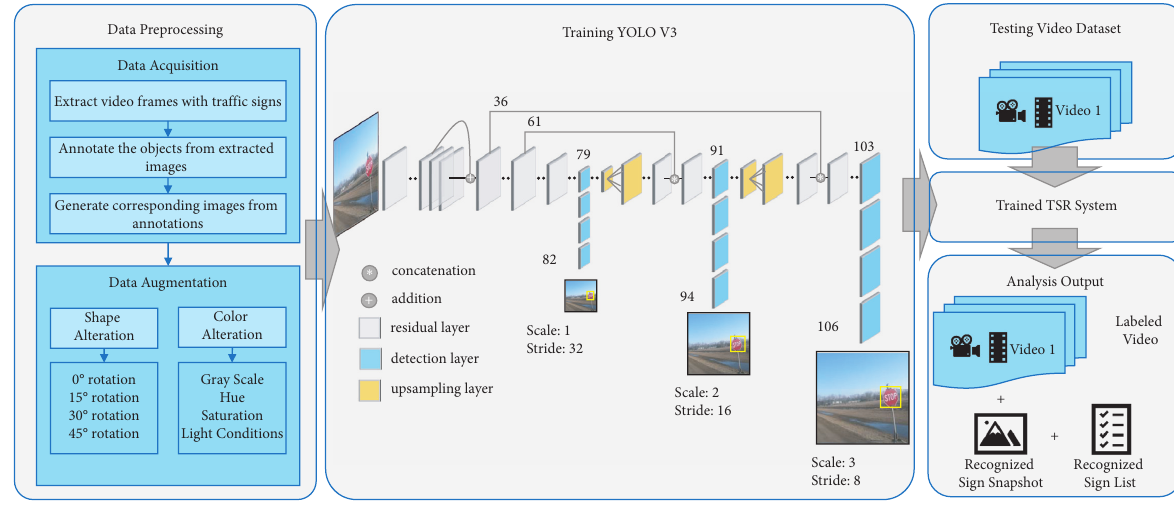
Figure 3: Flow chart of the developed TSR system. Table 2: Information on training traffic sign image datasets for each version of the TSR